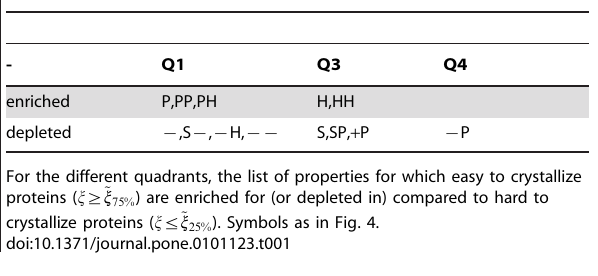
Table 1. Kolmogorov-Smirnov test between high and low crystallization propensity proteins in different sSCE-sGRAVY